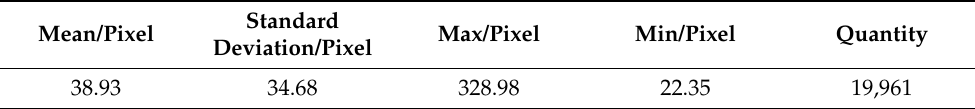
Table 3. Particle equivalent diameter distribution parameter table.